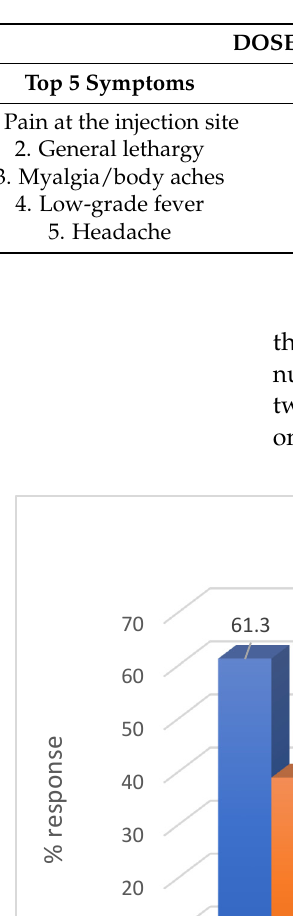
Table 2. The most common adverse effects postdose one and dose two of Sinopharm vaccination.